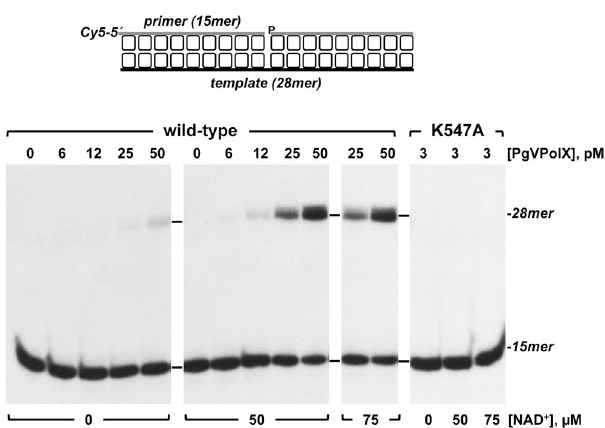
Figure 5. Ligation of nicked DNA by PgVPolX. The assay was performed as described in Materials and Methods with 1 nM of the 32 P-5 ′ -labeled substrate depicted on top of the figure and the indicated concentrations of either the wild-type or mutant PgVPolX and of NAD +